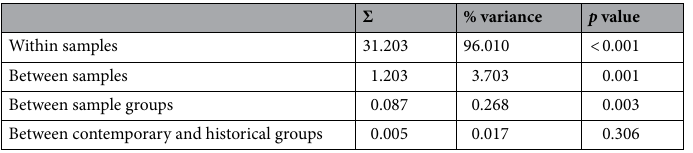
Table 3. Variance of the eastern Atlantic and Mediterranean BFT samples as computed by AMOVAs using a hierarchical approach as indicated by the four